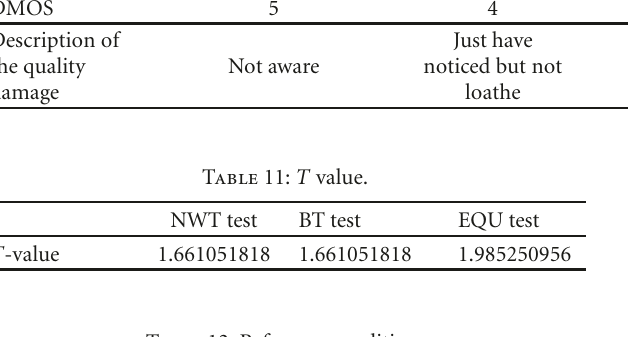
Table 12: Reference